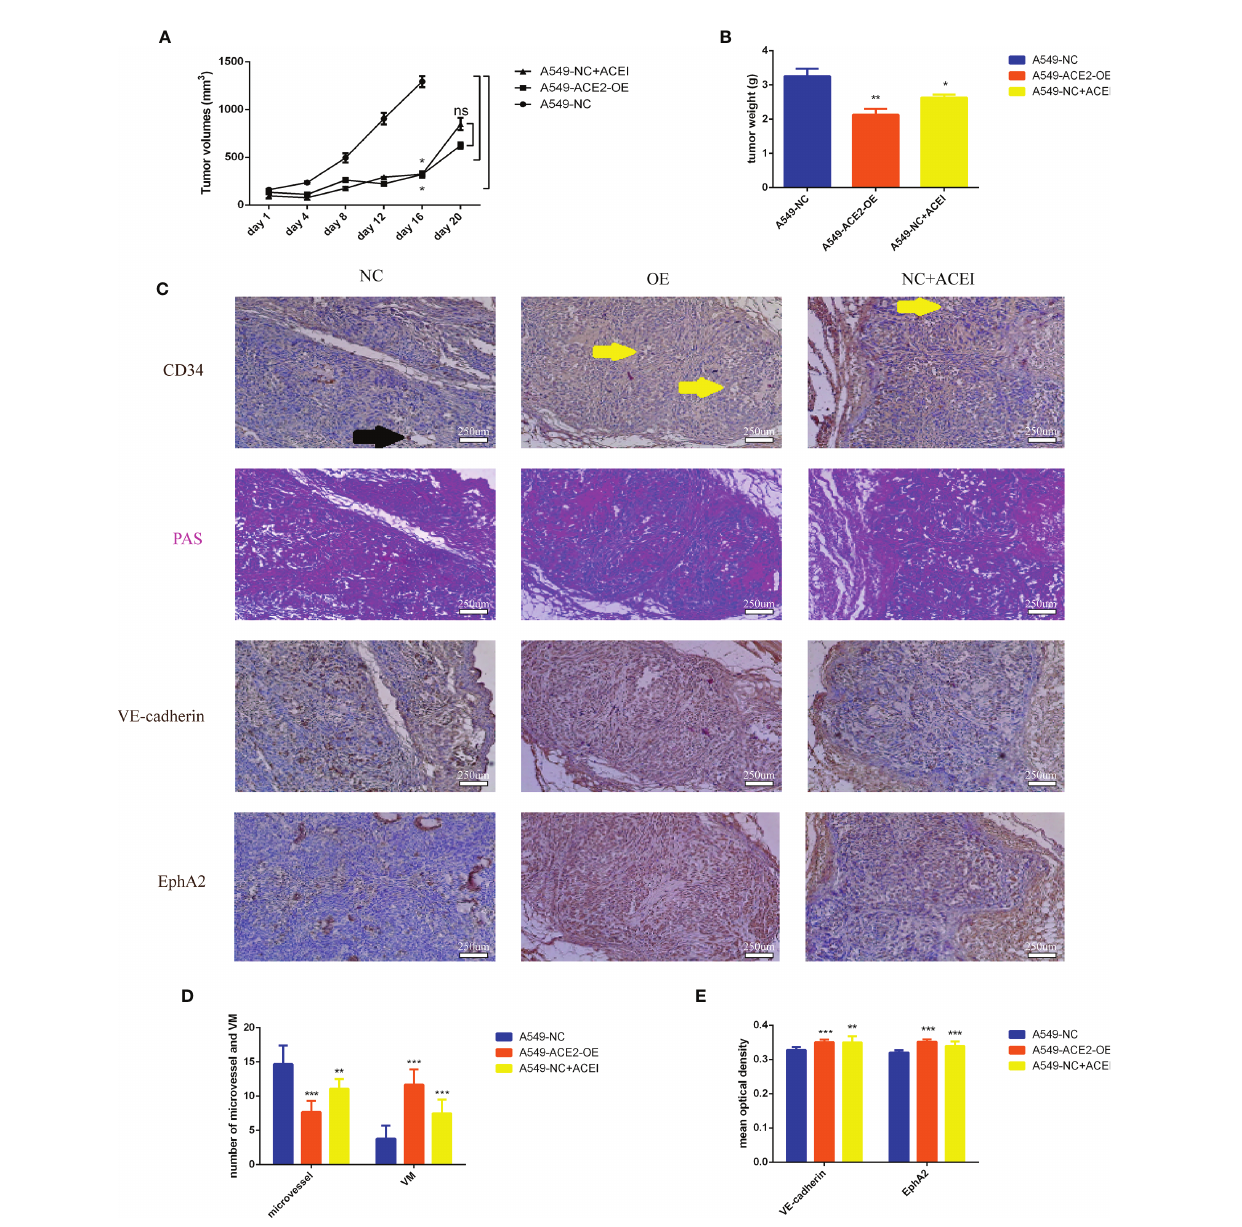
FIGURE 5 | VM formation was increased, and vasculature was lessened due to inhibition of RAS in vivo . (A) Growth curve of allograft tumors of A549-ACE2-OE cells, A549-NC cells with or without ACEI treatment, Mean ± SD, n = 3, *p < 0.05. ns, no signi fi cance. (B) Weight of resected tumors, Mean ± SD, n = 3, **p < 0.01, *p < 0.05. (C) Continuous sections of allograft tumor tissues stained with PAS, CD34, VE-cadherin, or EphA2 immunohistochemical stain. Black arrow points out a typical MV (CD34 + /PAS − ); yellow arrows point out typical VM (CD34 − /PAS + ). (D) Quanti fi cation of MV and VM in different groups, Mean ± SD, n = 3, per fi eld, ***p < 0.001, **p < 0.01. (E) Quanti fi cation of VE-cadherin and EphA2 mean optical density in three groups, Mean ± SD, n = 3, ***p < 0.001, **p <